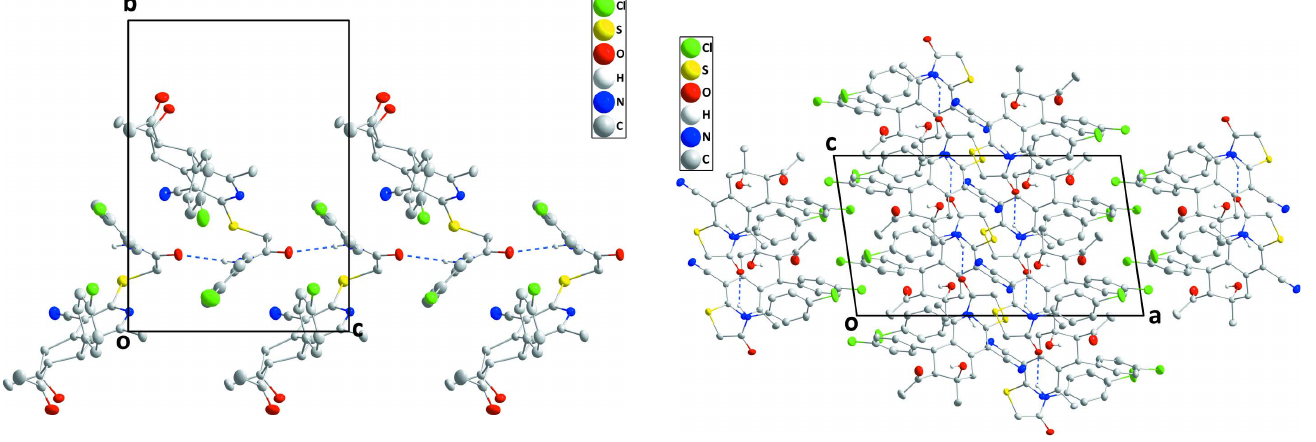
Figure 2 A portion of one chain viewed along the a -axis direction with the intermolecular N—H (cid:2)(cid:2)(cid:2) O hydrogen bonds depicted by dashed lines.